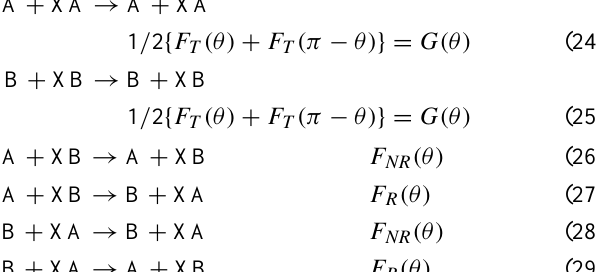
tering angle is